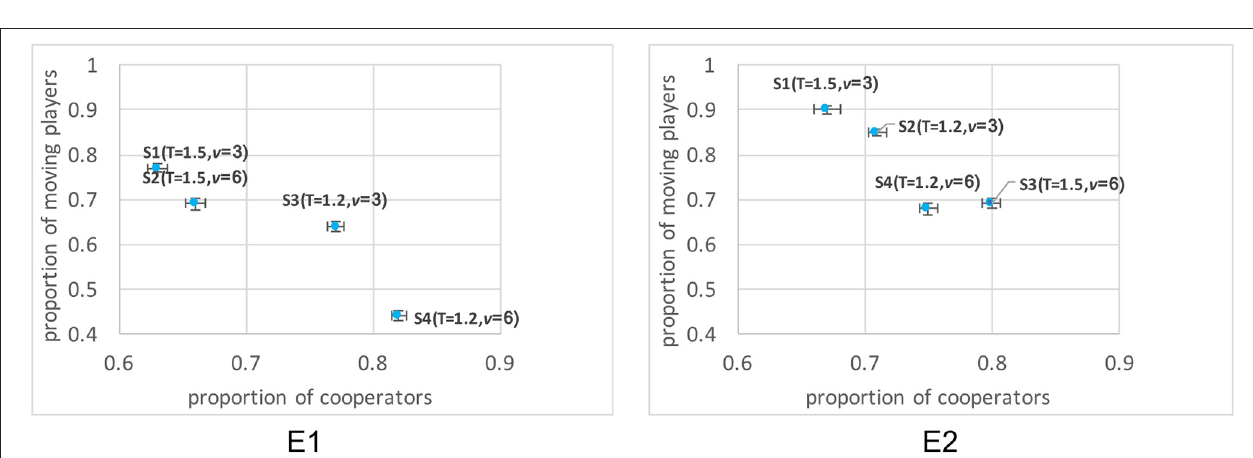
the focal player moved, CHA: the number of time steps in which the focal player changed her strategy, SCO: the total score that the focal player obtained, in each